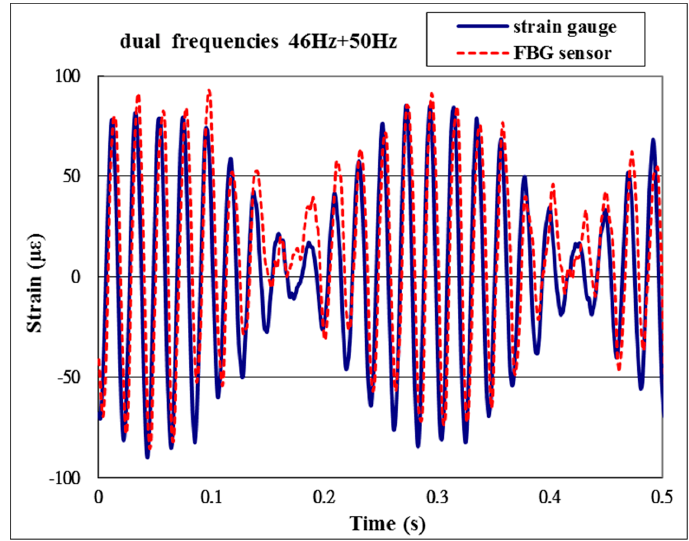
Figure 10. Vibrational response of a cantilever beam subjected to dual frequencies base excitation.